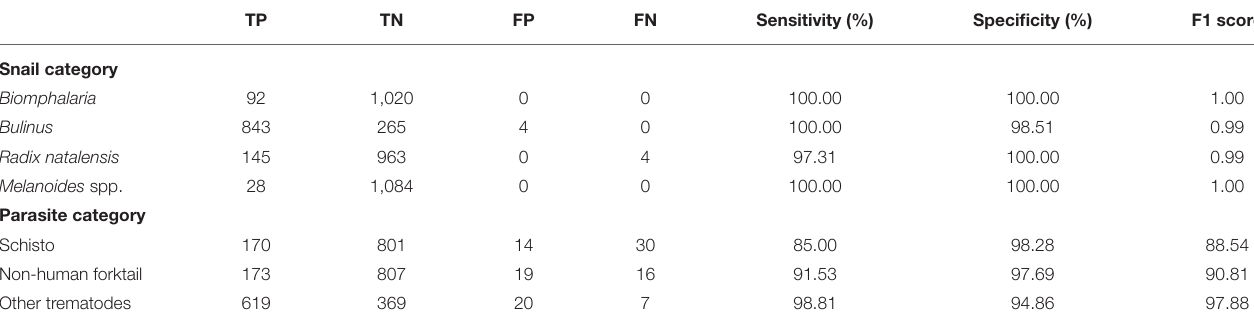
TABLE 2 | Results of the identification of snails and cercaria by the best CNN model. TP TN FP FN Sensitivity (%) Specificity (%) F1